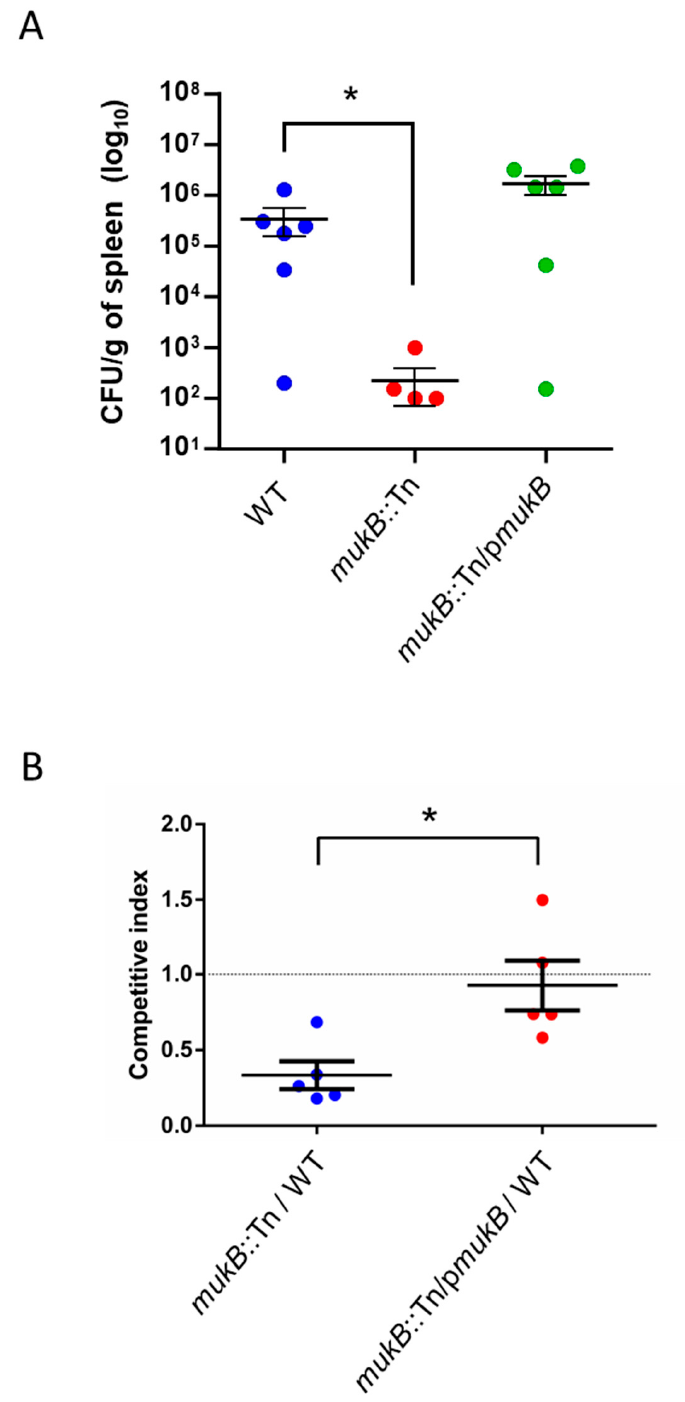
Figure 3. MukB is the necessary gene for proliferation of V. vulnificus in the systemic circula- tion. ( A ) Bacterial burdens in the spleen of mice subcutaneously inoculated with WT, mukB ::Tn, or mukB ::Tn/p mukB assessed as CFU/g at 12 h post-infection. Each symbol represents an individ- ual mouse ( n = 6/group). Error bars indicate standard error of mean (SEM). Statistical analyses: Kruskal-Wallis with Dunn’s multiple comparison (* p < 0.05). ( B ) Bacterial burdens in the spleen of mice subcutaneously inoculated with WT, mukB ::Tn, and mukB ::Tn/p mukB assessed as CFU/g at 6 h post-infection. Each symbol represents an individual mouse ( n = 5/group). Error bars indicate SEM. Statistical analyses: Mann-Whitney U -test (* p < 0.05). CFU, Colony forming